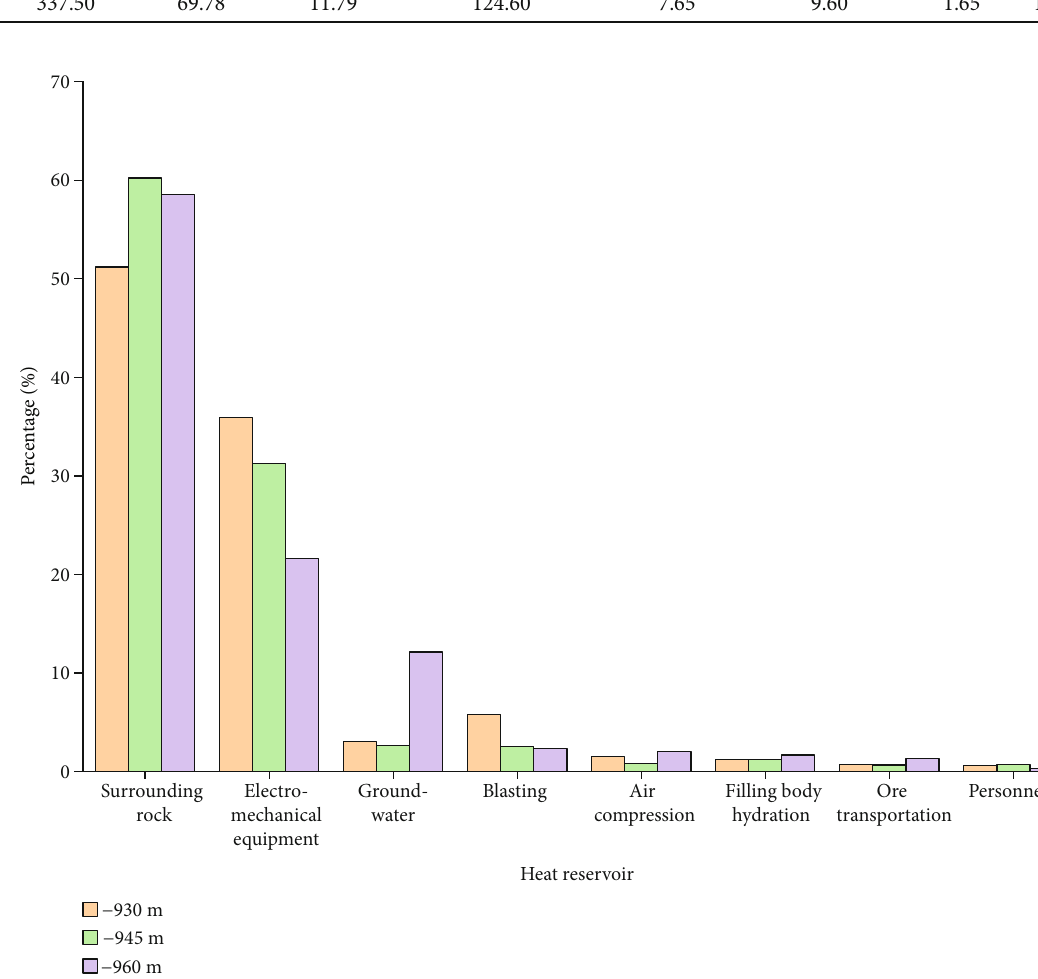
Figure 2: Heat release ratio of various heat sources in each